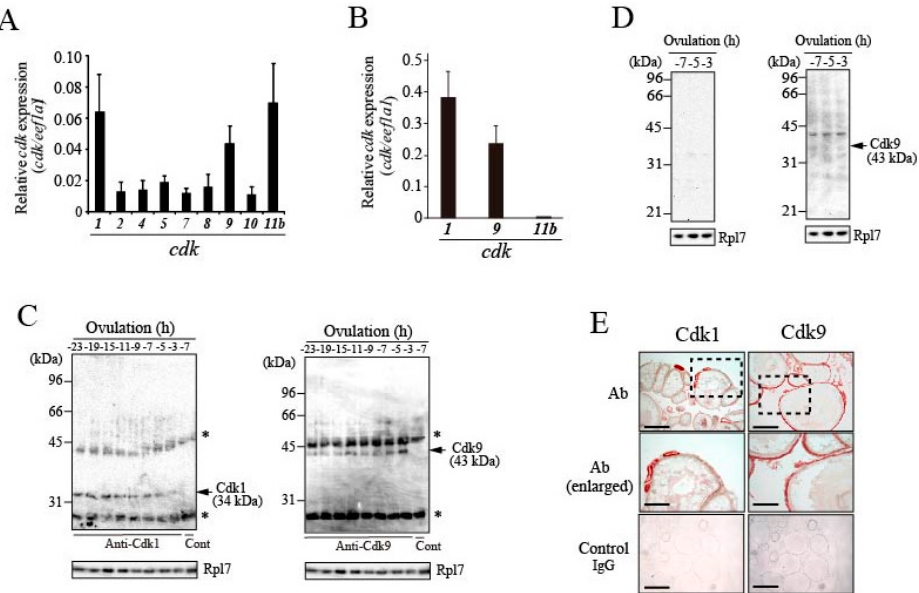
Figure 5. Expression of Cdks in the medaka ovary. ( A ) Relative expression levels of cdk transcripts were determined by real-time RT-PCR using total RNAs isolated from follicle layers of preovulatory follicles isolated 6 h before ovulation. ( B ) Relative expression levels of cdk1, cdk9, and cdk11b transcripts were determined by real-time RT-PCR using total RNAs from granulosa cells isolated from the − 6